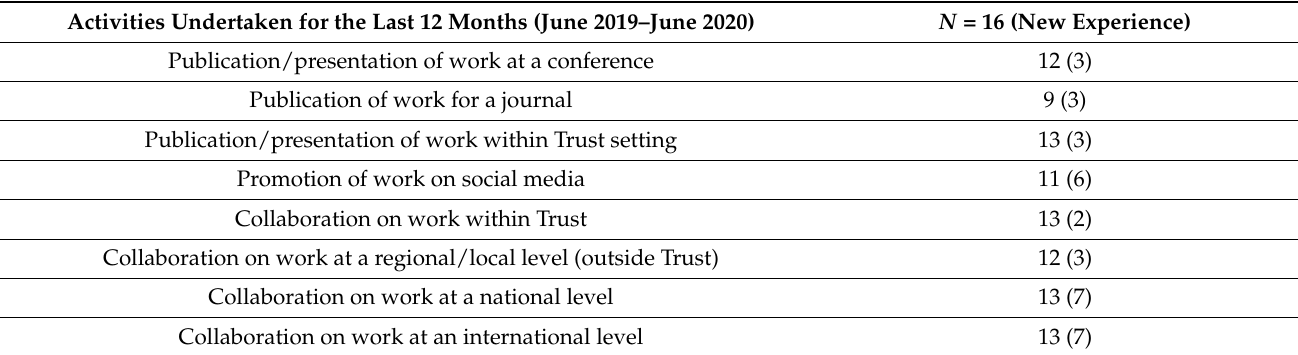
Table 3. Professional activities undertaken by CPhOGH Fellows during the Fellowship year, including new